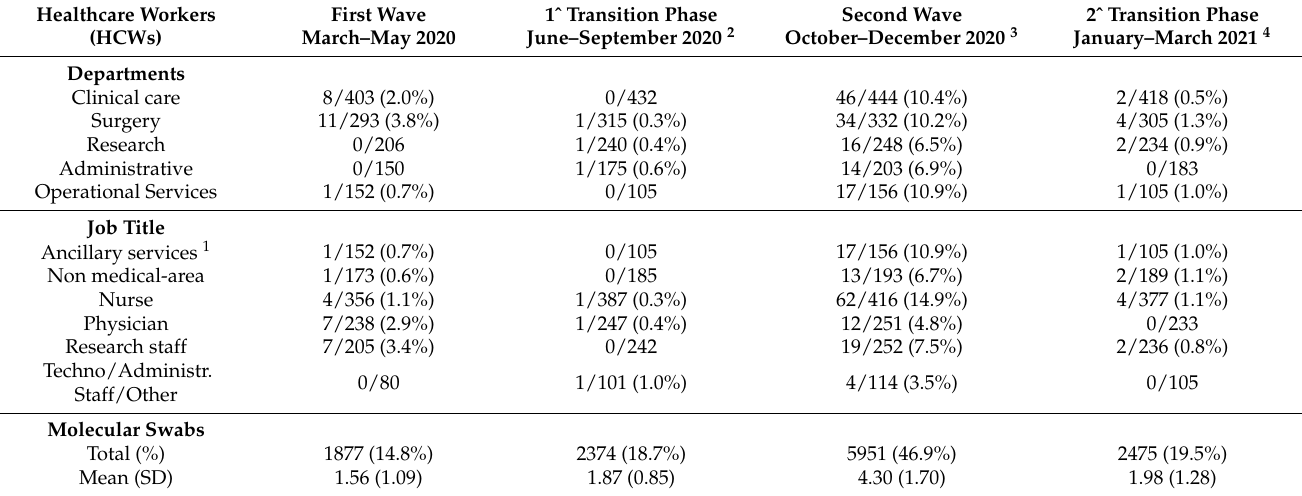
Table 2. SARS-CoV-2 incidence rate of Healthcare Workers (HCWs; N = 1510) from the first to the second wave of the pandemic.